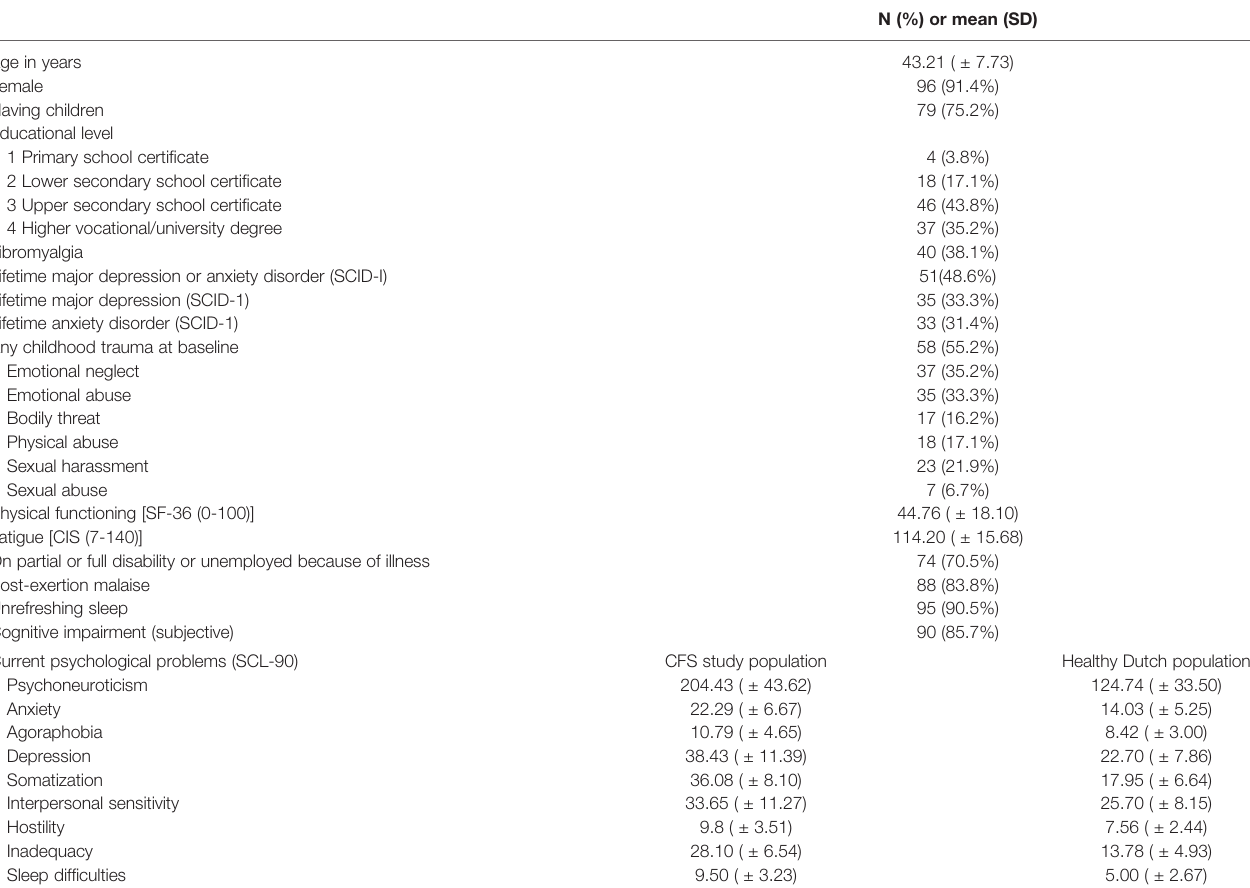
TABLE 2 | Baseline demographic and clinical characteristics of the study group